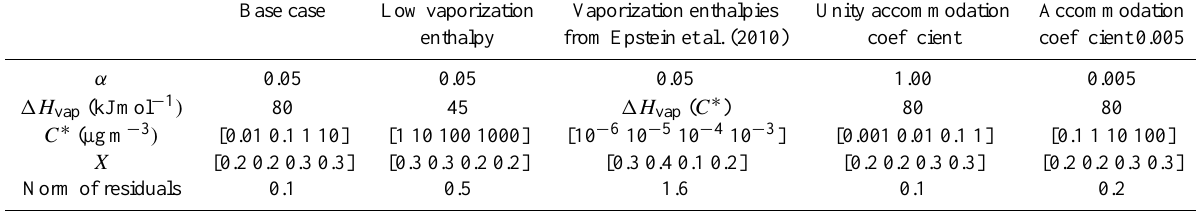
Table 1. The input parameters ( α is the effective mass accommodation coefficient, 1H vap the vaporization enthalpy) in the model calcu- lations, and the corresponding mass fractions on each volatility in the aerosol phase, as determined from least squares fits of modeled to measured VFR data. The norm of residuals describes the goodness of the fit.